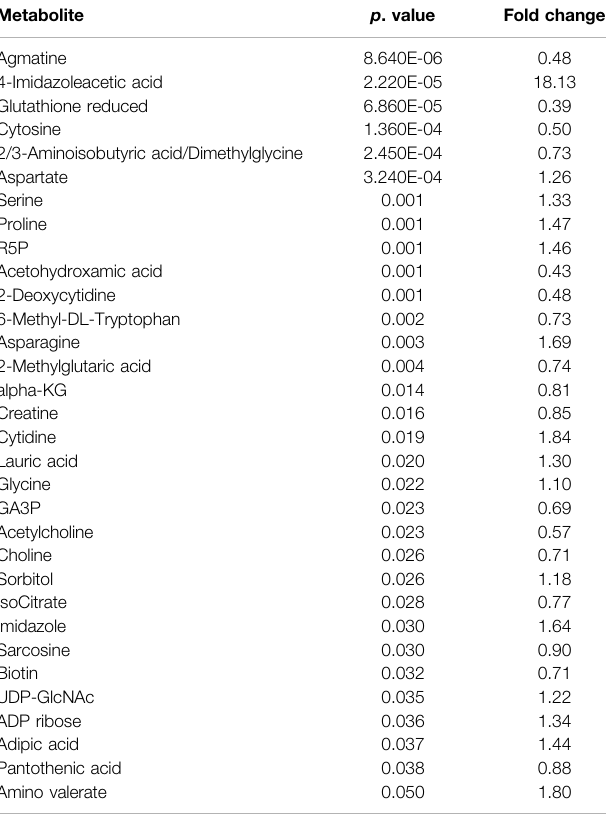
TABLE 2 | The disturbed metabolites with p < 0.05 in 80 μ M EGCG-treated A549 cells compared to controls. Metabolite p . value Fold change Agmatine